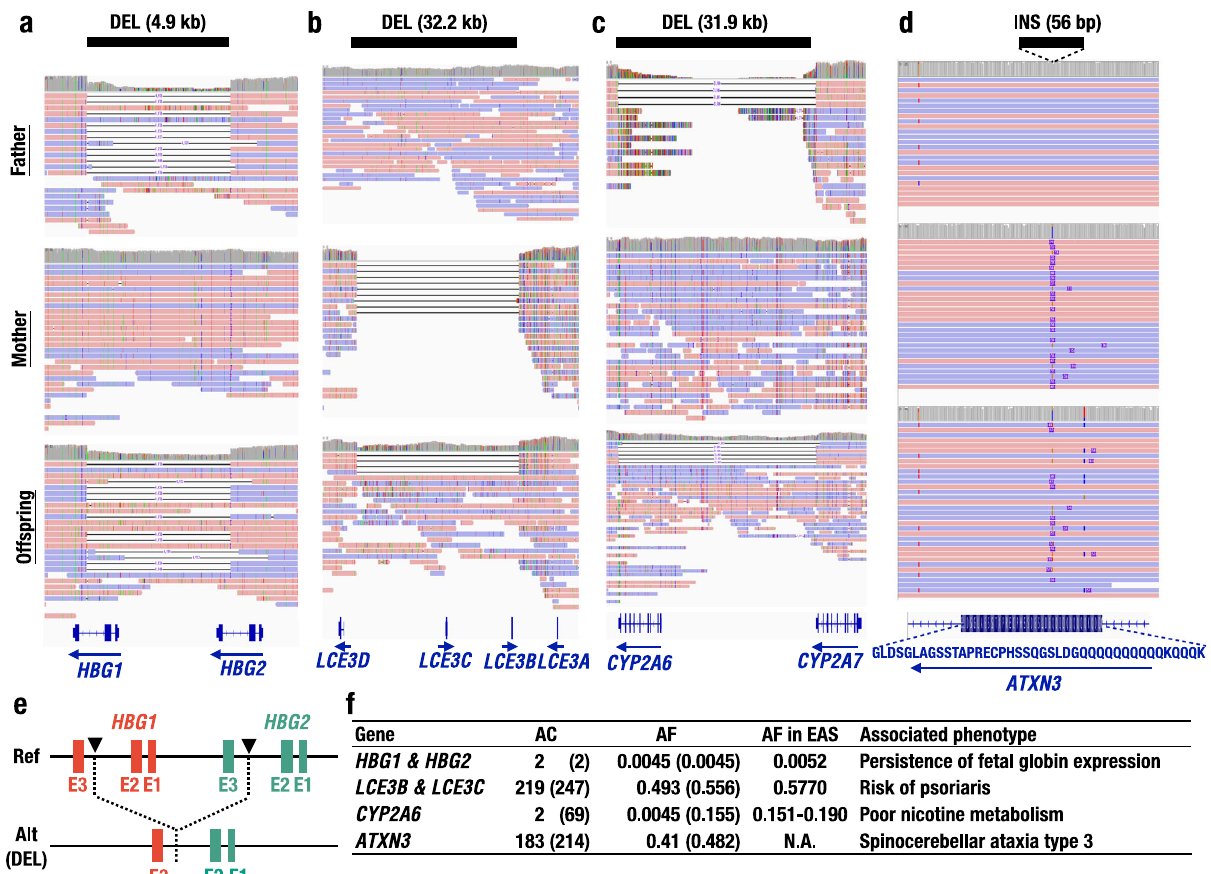
Fig. 6 SVs associated with clinical phenotypes. a – c SVs overlapping with the protein-coding sequences of HBA1 and HBG2 ( a ), LCE3B and LCE3C ( b ), CYP2A6 ( c ), and ATXN3 ( d ). The positions of the SVs are indicated as black bars, and the sizes are shown in parentheses. e Schematic of the 4.9 kb DEL between the HBG1 and HBG2 loci. Notably, this DEL produces the HBG1 - HBG2 fusion gene. The breakpoints are shown as arrowheads. f Allele frequency and clinical phenotypes associated with the SVs shown in a – d . AC allele count, AF allele frequency; and AF in EAS, publicly available AF value in the East Asian population 25, 58, 59 . AC and AF based on manual inspections are shown in